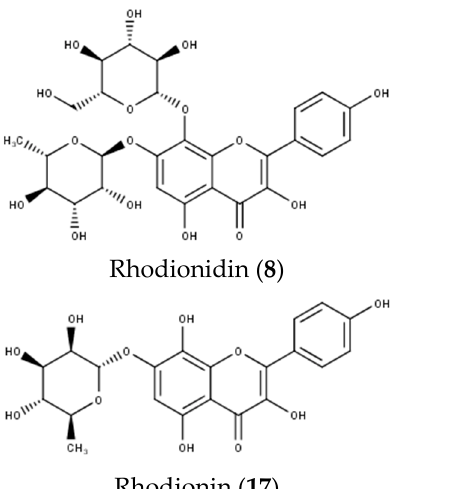
Figure 3. Structures of proposed phenylpropanoids ( 9 , 11 – 13 , 15 ).